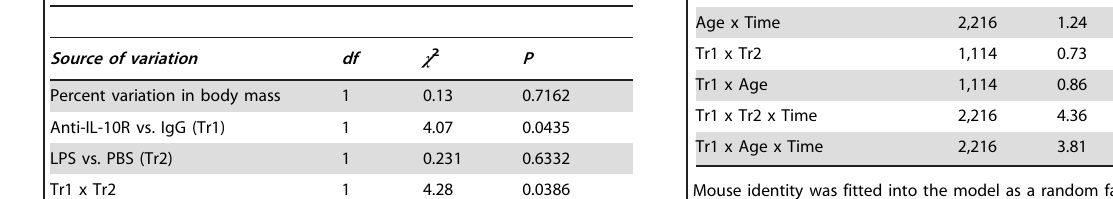
Table 1. Log-linear model reporting the effect of the experimental treatments and body mass variation (percent variation in body mass between day 0 and day 2) on the survival rate of 15 months old mice.